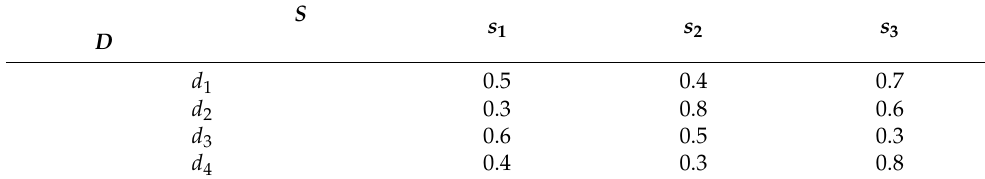
Table 1. Decision-making